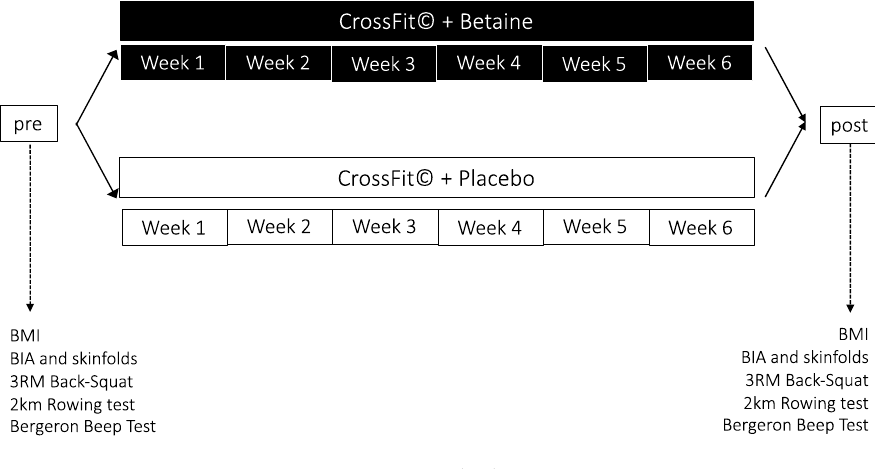
Figure 1. Study design.